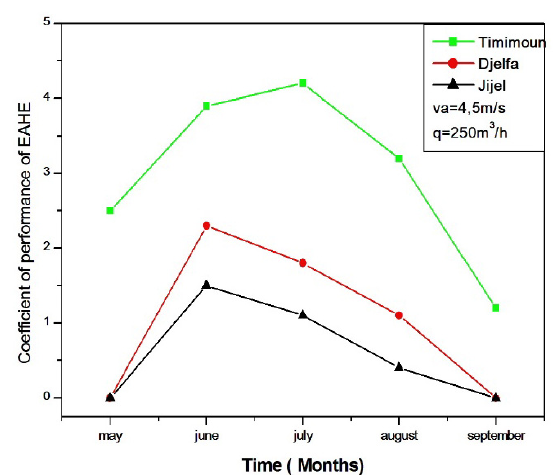
Figure 10. The monthly cooling energy provided by the EAHE for different